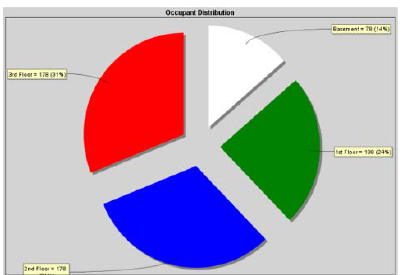
Figure 8. Pie Chart visualization of the GAMA simulation